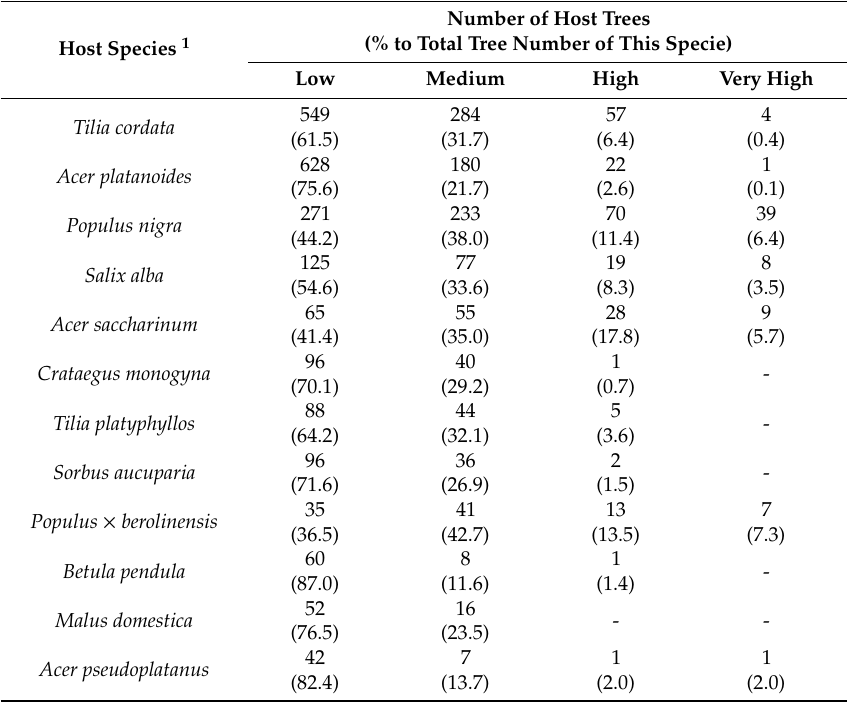
Table 2. Distribution of various tree species according to the degree of infection with